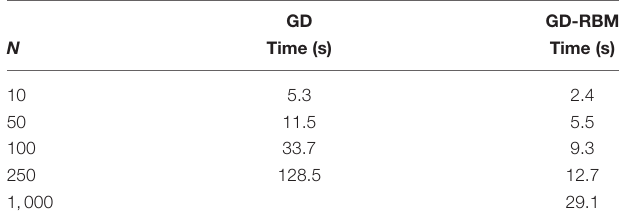
10 oscillators and K > K * (left) and K < 0 (right) . = TABLE 1 | Computational times required by the GD and GD-RBM algorithm to u with increasing values of N compute the optimal control b